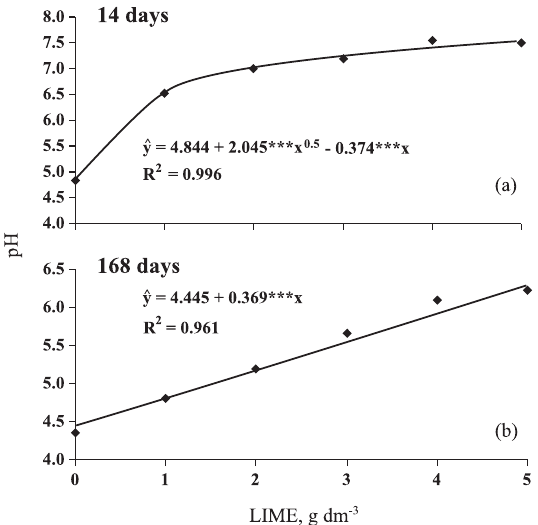
Figure 3. Leachate pH as a variable of lime rate at 14 (a) and 168 (b) days after application to the growth